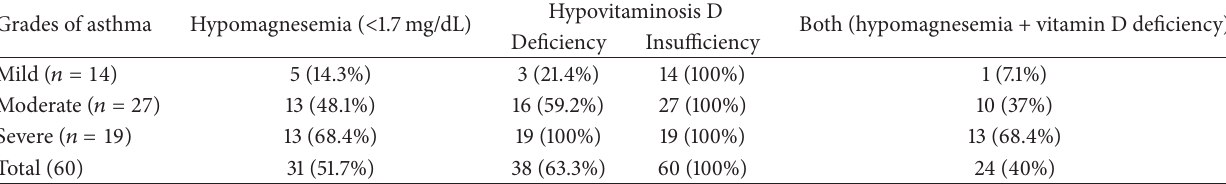
Table 5: Prevalence of hypomagnesemia and hypovitaminosis D in the different grades of asthma severity.